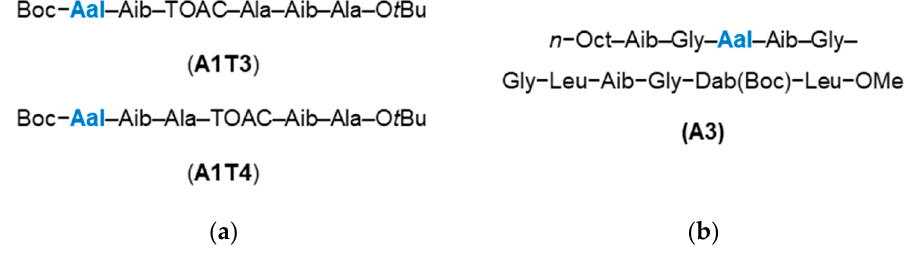
Figure 14. Aal-bearing peptides synthesised by Pispisa et al. in ( a ) 2004 [76] and ( b ) 2005 [77]. Aib = 2-Aminoisobutyric acid; Dab = 2,4-diaminobutyric acid.